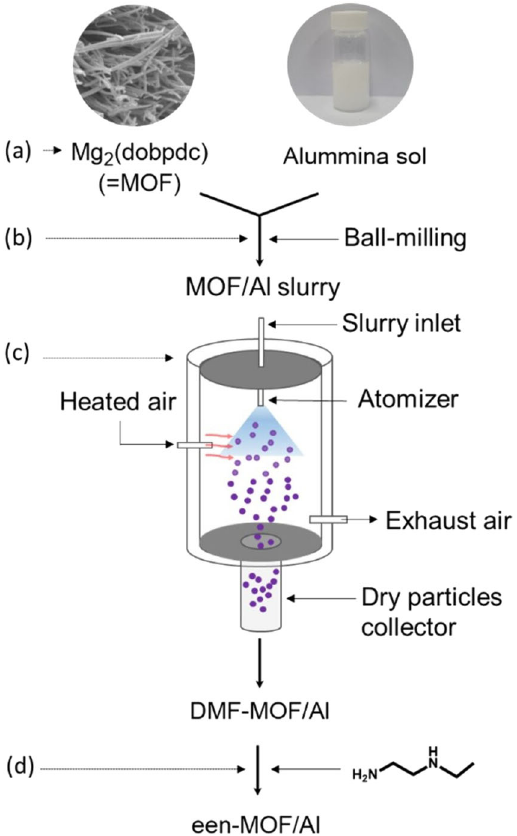
Fig. 1 Schematic of the spray-drying process of MOF/Al microbeads. a Scale-up synthesis of Mg 2 (dobpdc) using 300mL and 35L steel bomb reactors. b Mixing Mg 2 (dobpdc) and alumina sol binders through a ball- milling process. c Shaping of MOF/Al microbeads via spray dry